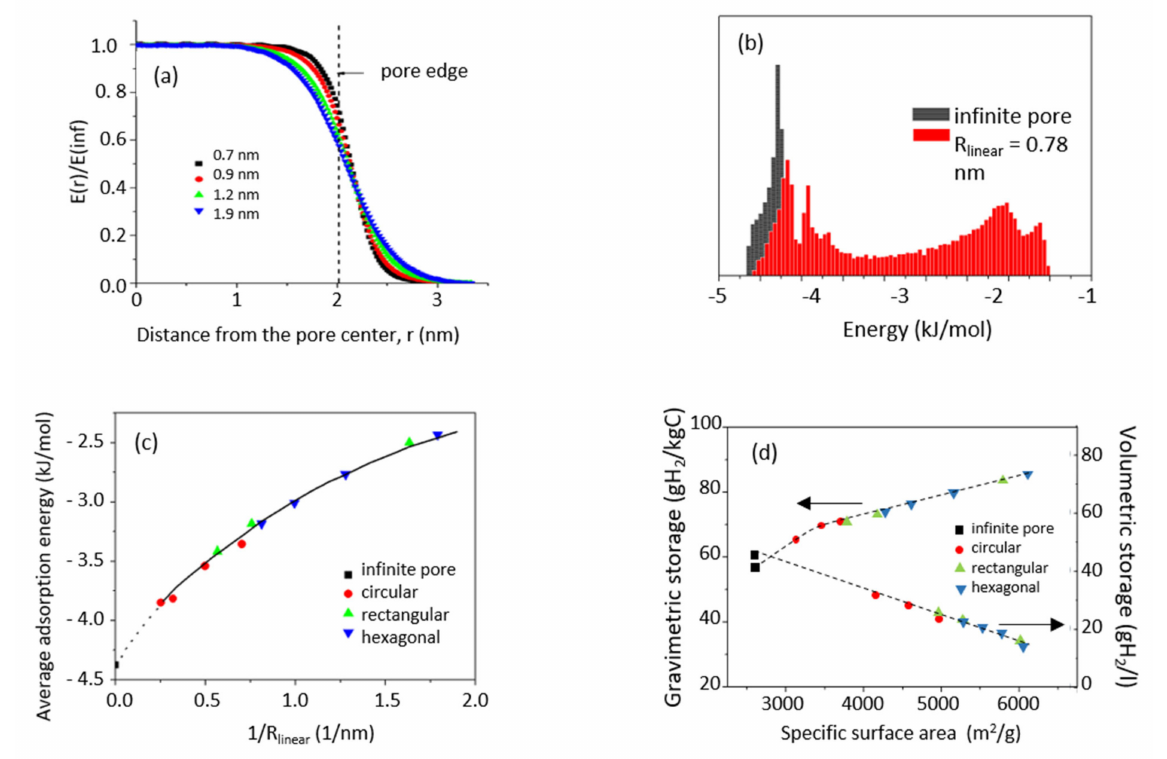
Figure 2. ( a ) Variation of the potential energy of a H 2 molecule adsorbed in the mirror plane of a pore delimited by circular walls of the radius of 2 nm for four pore widths; ( b ) distribution of hydrogen adsorption energy on circular graphene fragment of the radius of 0.78 nm. For comparison the distribution of adsorption energy on infinite graphene surface is also shown (in black); ( c ) variation of average H 2 adsorption energy in a function of graphene fragment size and shape: R linear = (S fragment / π ) 1/2 ; ( d ) gravimetric and volumetric storage capacity vs. specific surface area of the model pore at the width of 1.5 nm, at p = 100